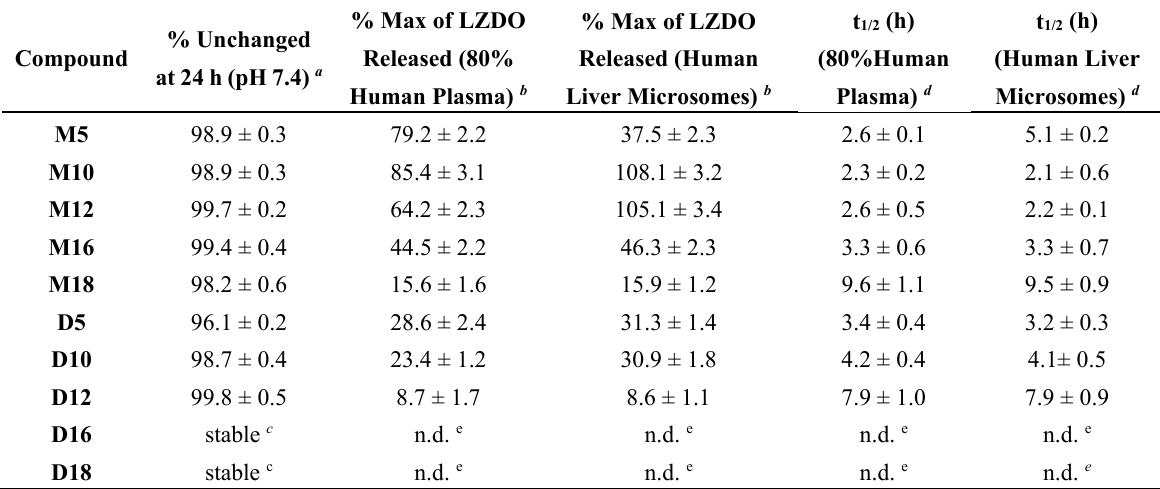
Table 3. Stability of the prodrugs in buffered solutions, human serum and human liver microsomes ( n = 3; mean ±